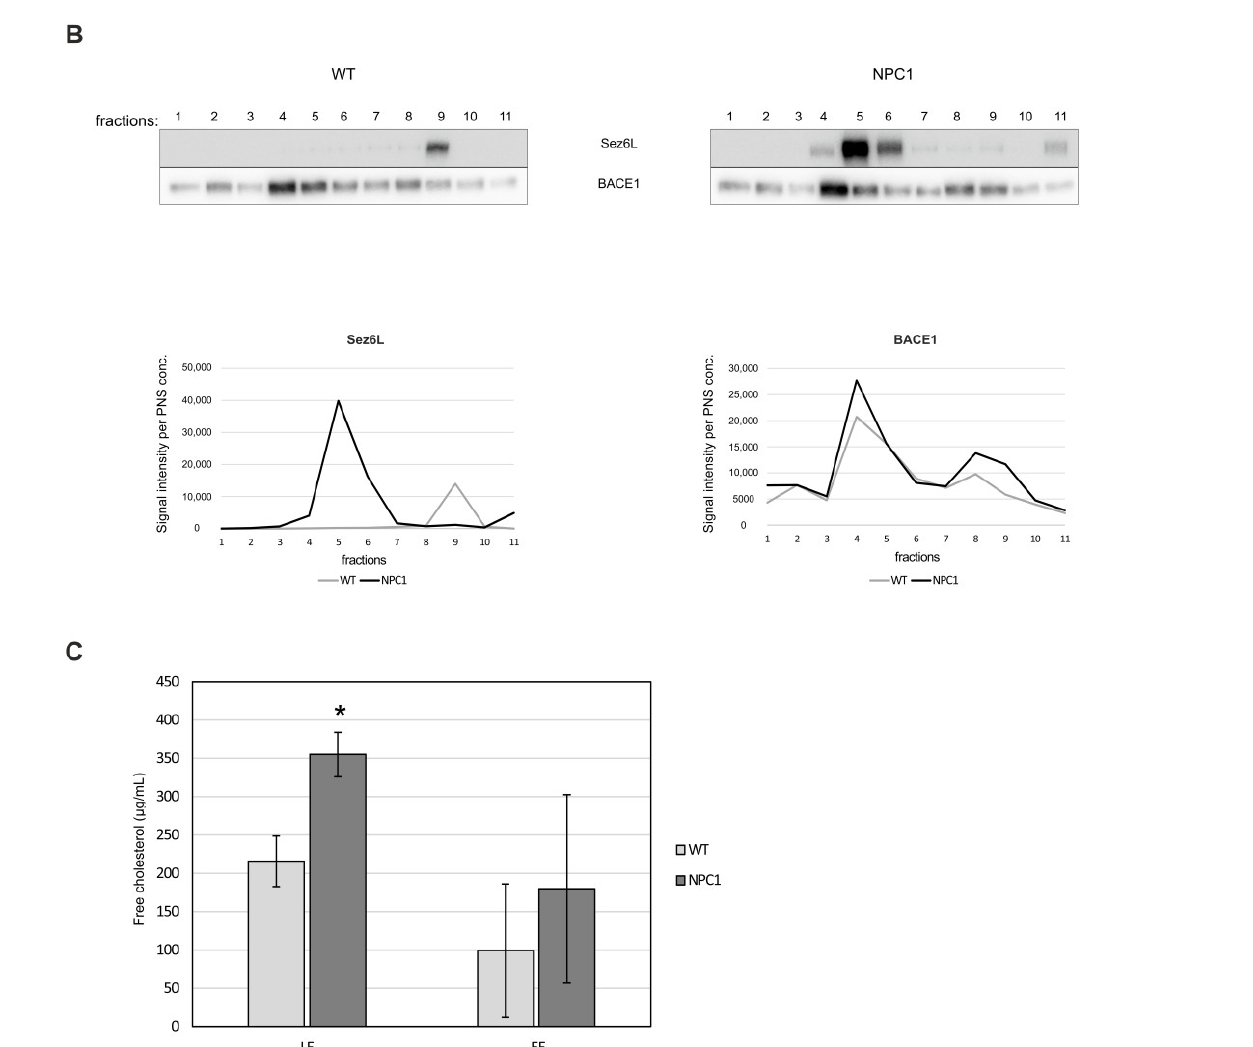
Figure 5. Endosomal fractionation reveals an altered retromer and endocytic distribution between NPC1 and wt-mouse cerebella. Eleven cerebellar fractions (of 1 mL) of 10-week old wt and NPC1 mice were collected from the top of the gradient and were analyzed by Western blotting, as indicated in the material and methods section. ( A ) Western blot analyses of Vps35 (retromer complex protein), sorLA (sortilin-related receptor) and endocytic markers EEA1 (early endosomes), Rab7 (late endosomes) and LAMP1 (lysosomes). Graphs represent quantified protein signals of Vps35, sorLA, EEA1, Rab7 and LAMP1 in each fraction of wt and NPC1 mice, obtained by signal quantification using the ImageJ software, normalized to protein concentration in the corresponding PNS. ( B ) Western blot analyses of BACE1 substrate Sez6L and BACE1. Graphs represent quantified protein signals of Sez6L and BACE1 in each fraction of wt and NPC1 mice, obtained by signal quantification using the ImageJ software, normalized to protein concentration in the corresponding PNS. ( C ) The levels of free cholesterol were determined in early endosome (EE) and late endosome fractions (LE), fractions 4 and 5, and fractions 1 and 2, respectively, from the cerebellum of 10-week old NPC1 and wt-mice by Amplex Red cholesterol assay (Student’s t -test, * p < 0.05). The shown data are from three different experiments, n = 3 cerebella per